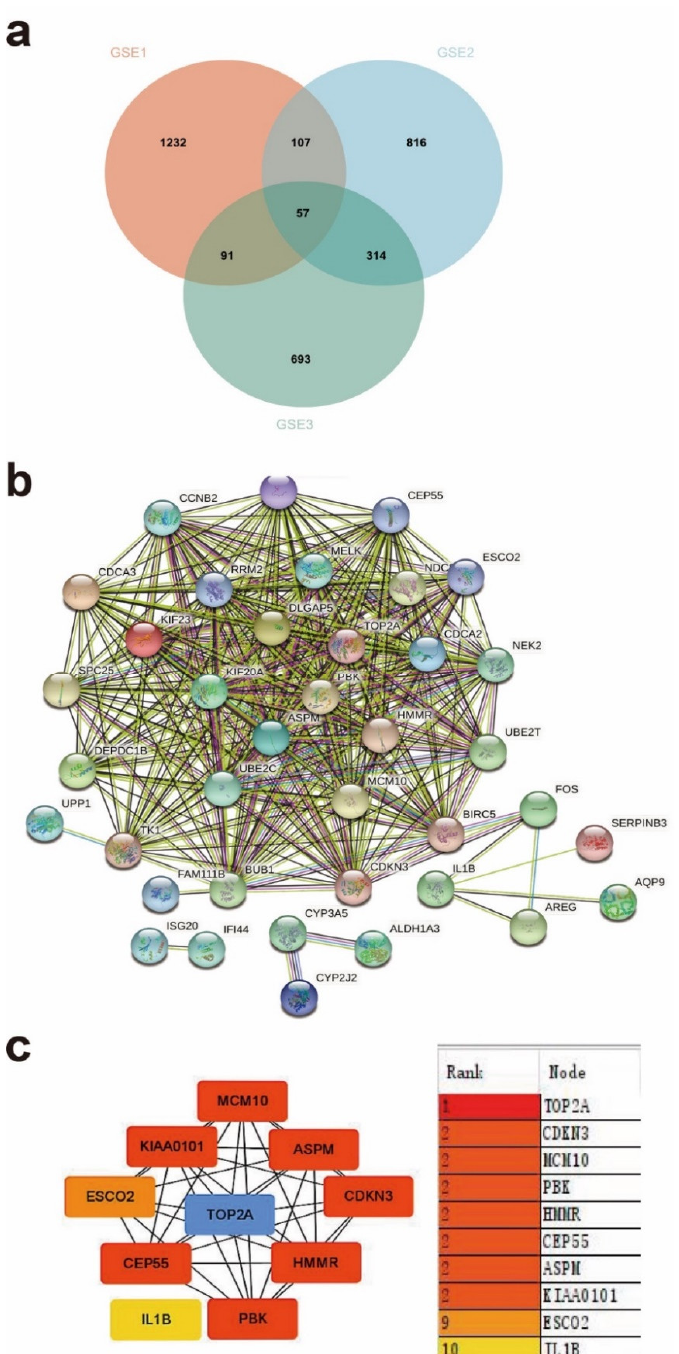
Figure 3. ( a ) Venn diagrams showing the overlaps of numbers of DEGs between three selected GEO datasets. ( b ) PPI network investigation. The interaction evidence degree between proteins is presented as the grayscale of the lines. ( c ) The top 10 hub genes were calculated by MCC in Cytoscape. Colors represent the importance of genes. The blue color stands for the highest degree, and the yellow color represents the lowest